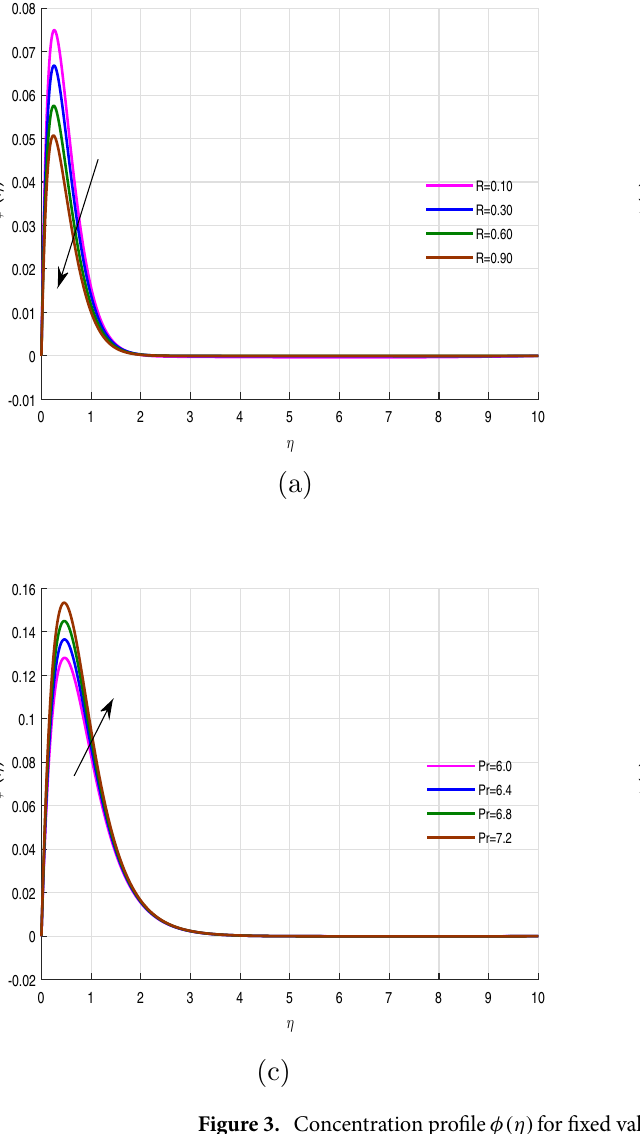
Figure 3. Concentration profile φ(η) for fixed values of physical parameters (cid:31) = 0.1 k = 8.933 , Pr = 6.0 , M = 0.5 , Gr = 0.09 , Gc = 0.05 , σ 1 = 1.1 , σ 2 = 10.9 , R = 0.5 , Ec = 0.6 , Nb = 0.01 , Nt = 0.1 Sc = 9.0 , fw = 1.0 , ϕ = 0.2 , n = 0.01 and β = 2.5